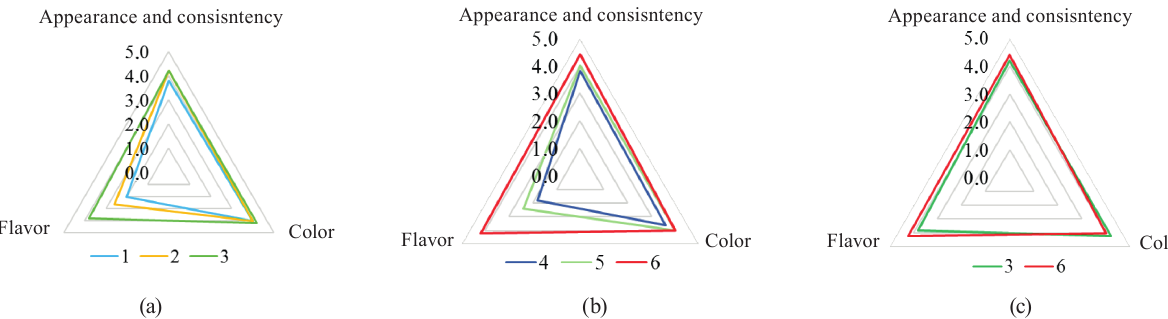
Figure 5 Sensory evaluation of the whey drink: (a) formulations 1–3; (b) formulations 4–6; (c) formulations 3 and 6, which proved optimal